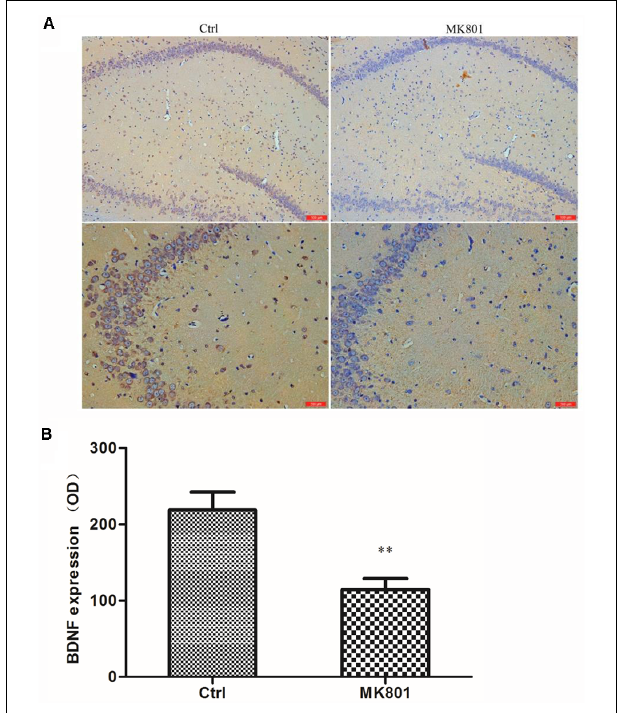
FIGURE 3 | BDNF immunoreactivity in the hippocampus of MK-801-treated rats. MK-801 was administered by daily injection (0.5 mg/kg body weight, i.p.) for 6 days. Control (Ctrl) animals received an equal volume of normal saline. (A) Weak BDNF immunoreactivity was detected in the hippocampus of optical density. Data represent mean ± SEM. Statistical differences between two groups were evaluated with the Student’s t -test. ∗∗ P < 0.01